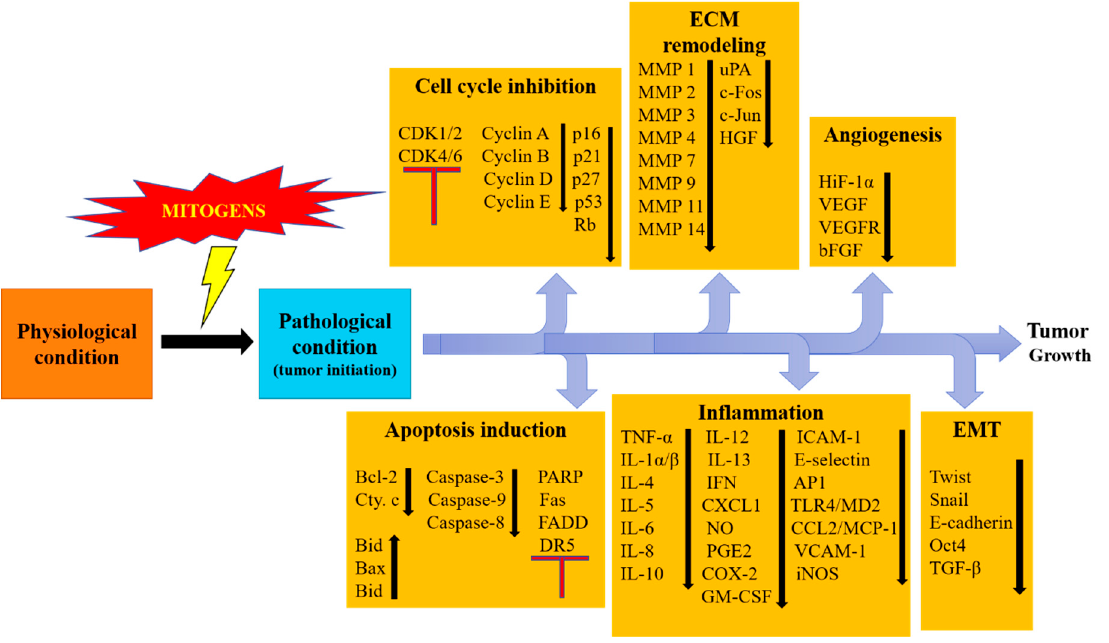
Figure 1. showing regulation of different cancer related processes under the effect of flavonoids. All these processes are crucial in carcinogenesis and play key roles for cancer initiation and progression. Flavonoids effectively act at these processes to inhibit cancer growth.